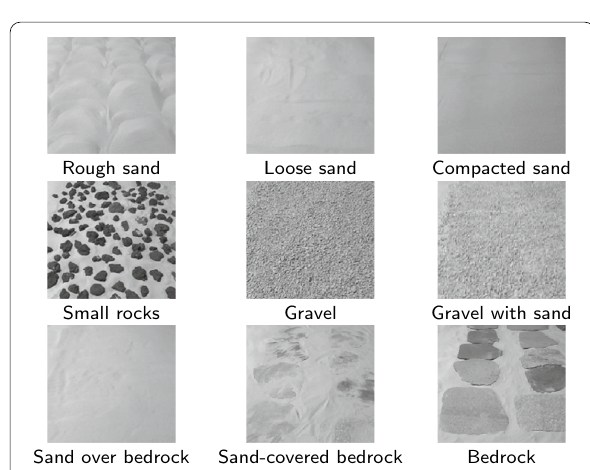
Fig. 4 Images of terrain surfaces tested in the